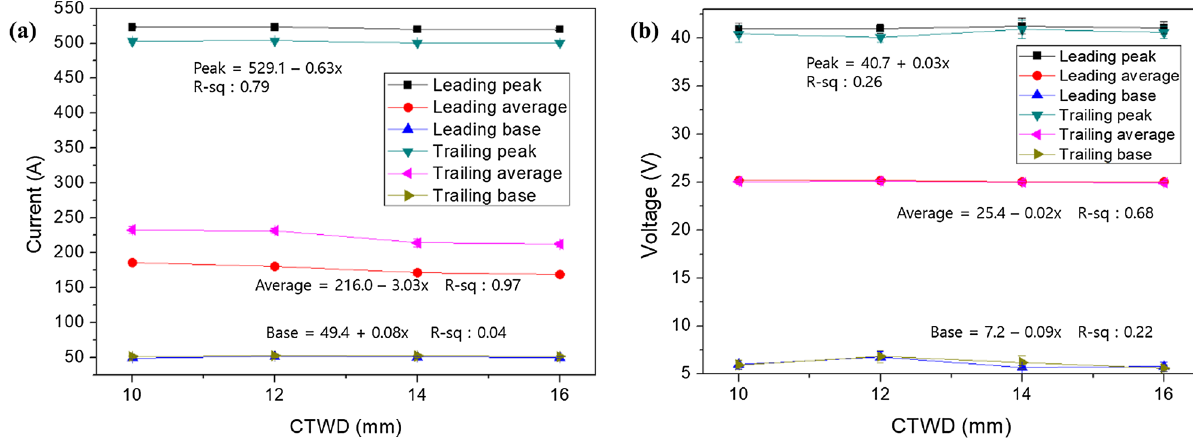
Figure 5. Regression analysis for seam tracking. ( a ) Current and ( b ) voltage variation with contact-to-work distance (CTWD) for wire feeding speed of 6 m/min.